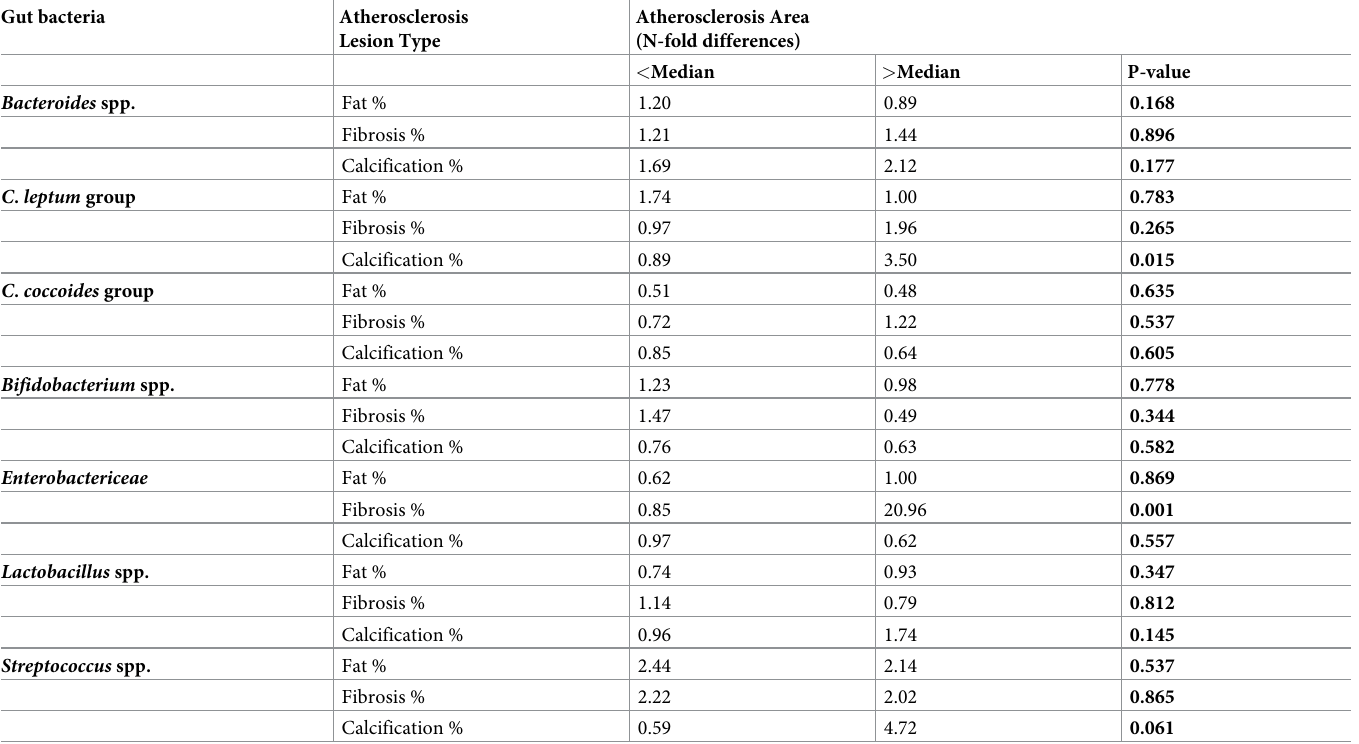
Table 3. The association of gut bacteria with atherosclerotic lesions. Gut bacteria Atherosclerosis